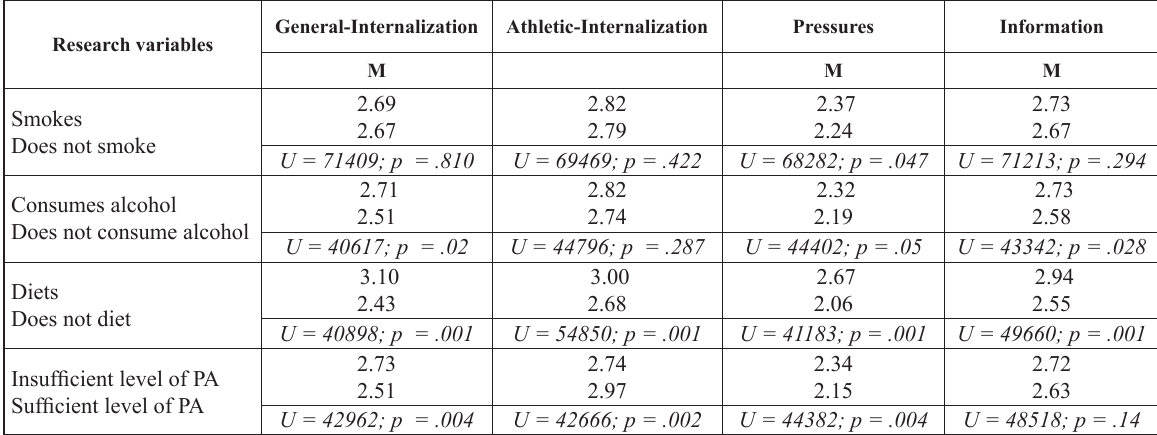
Research variables